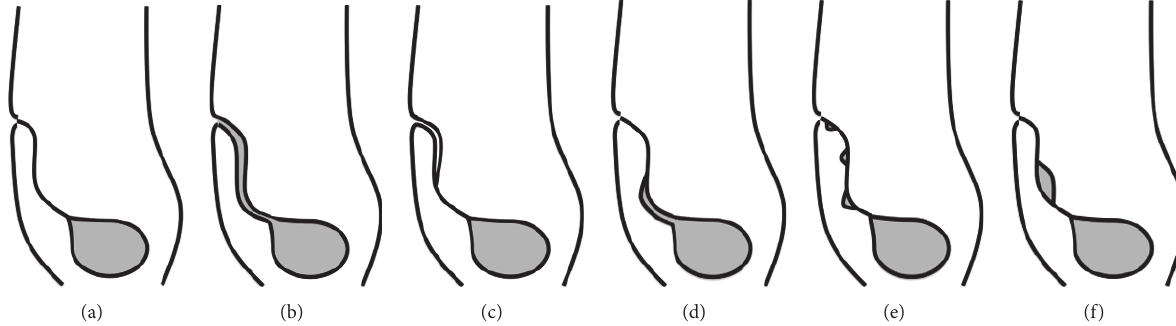
Figure 3: Congenital and acquired urachal abnormalities. (a) Normal urachus; (b) congenital patent urachus; (c) acquired umbilical urachal sinus; (d) acquired vesicourachal diverticulum; (e) acquired alternating urachal sinuses; (f) acquired urachal